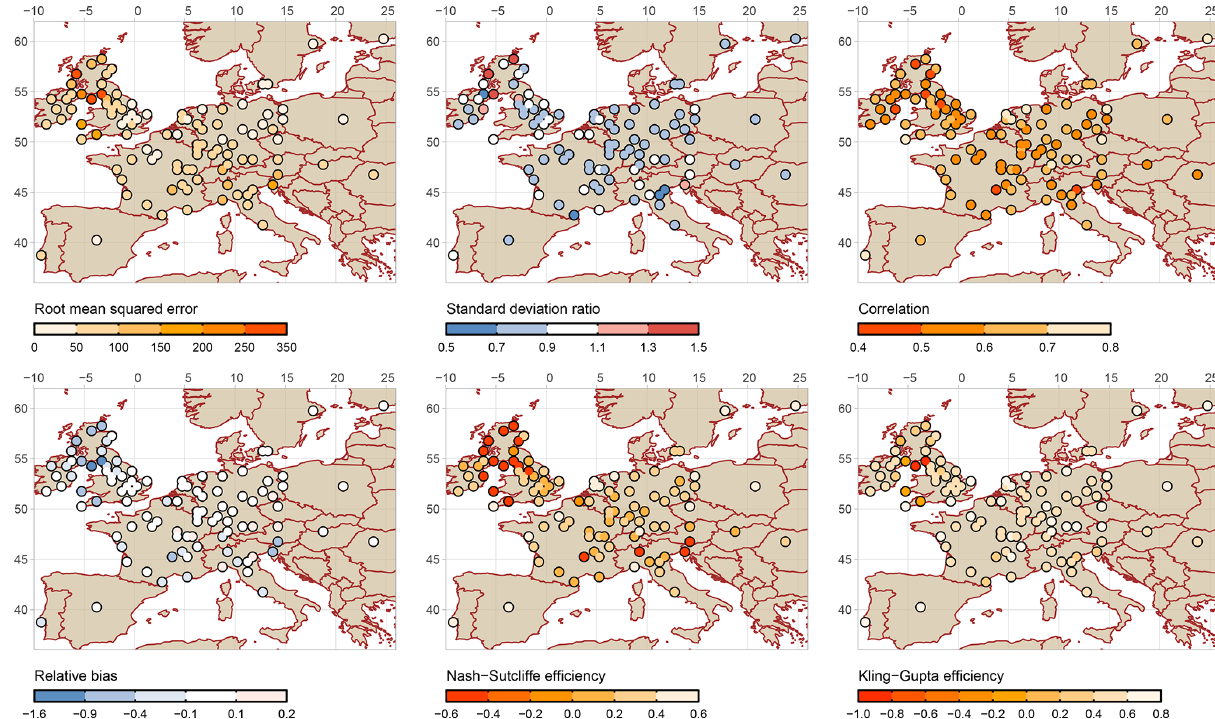
Figure 3. Validation of reconstructed precipitation (Pauling et al., 2006) against GHCN observations.